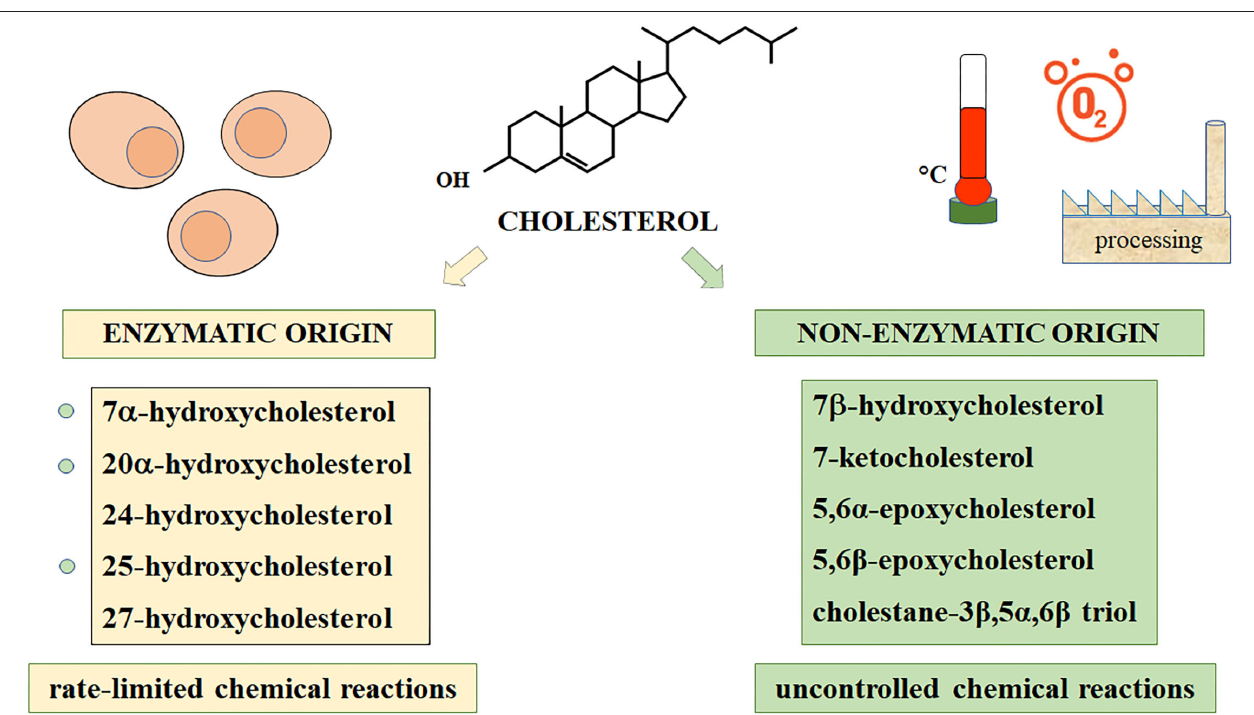
FIGURE 1 | Main oxysterols of enzymatic and non-enzymatic